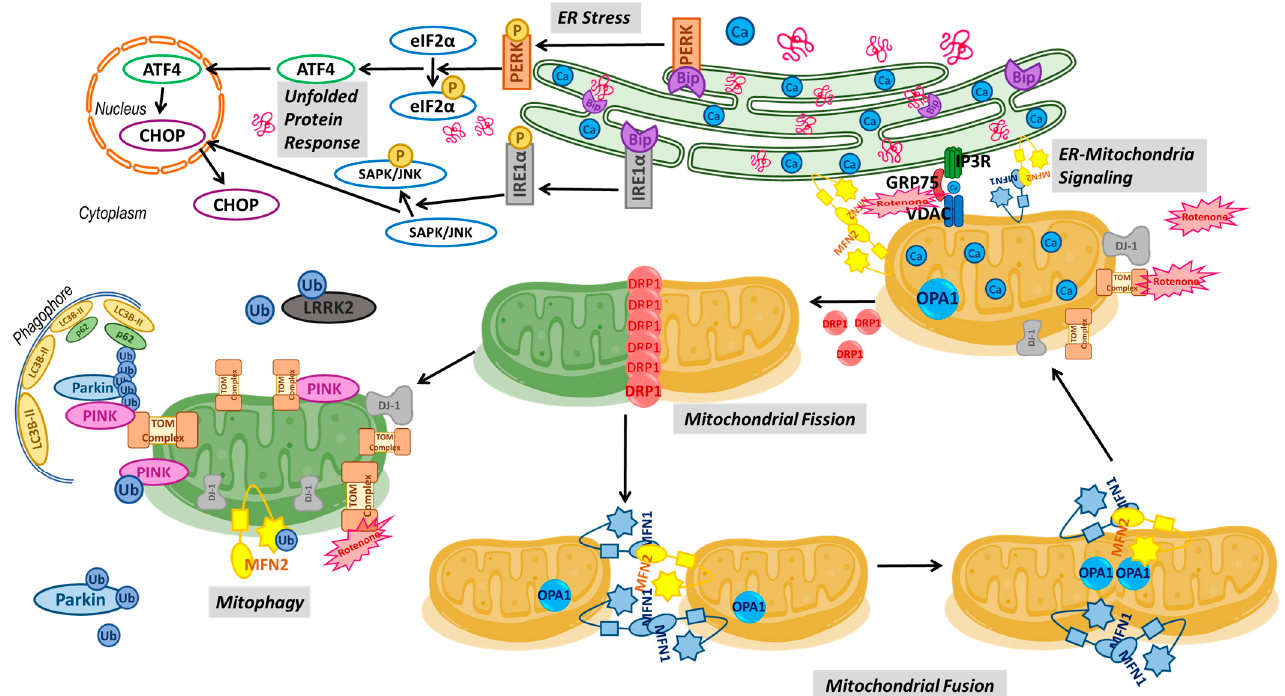
Figure 12. Schematic representation of the proposed mechanisms of the NI-ADSC-SM in response to ROT toxicity. ROT